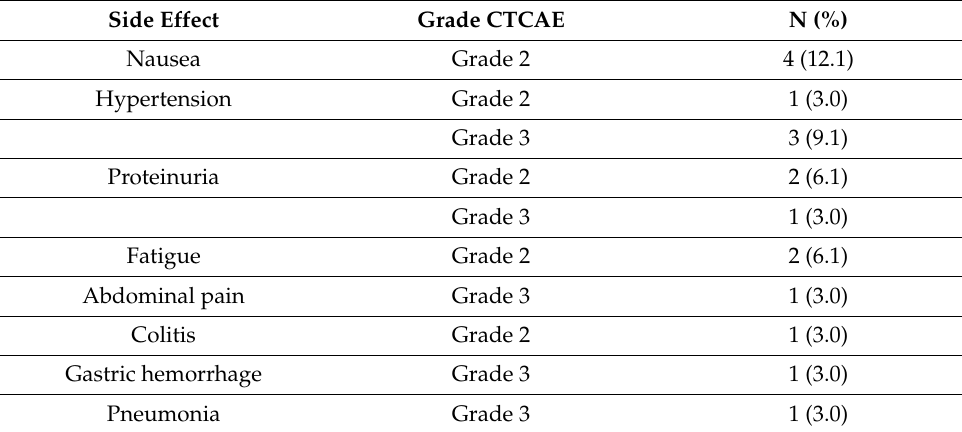
Table 3. Side effects during treatment with